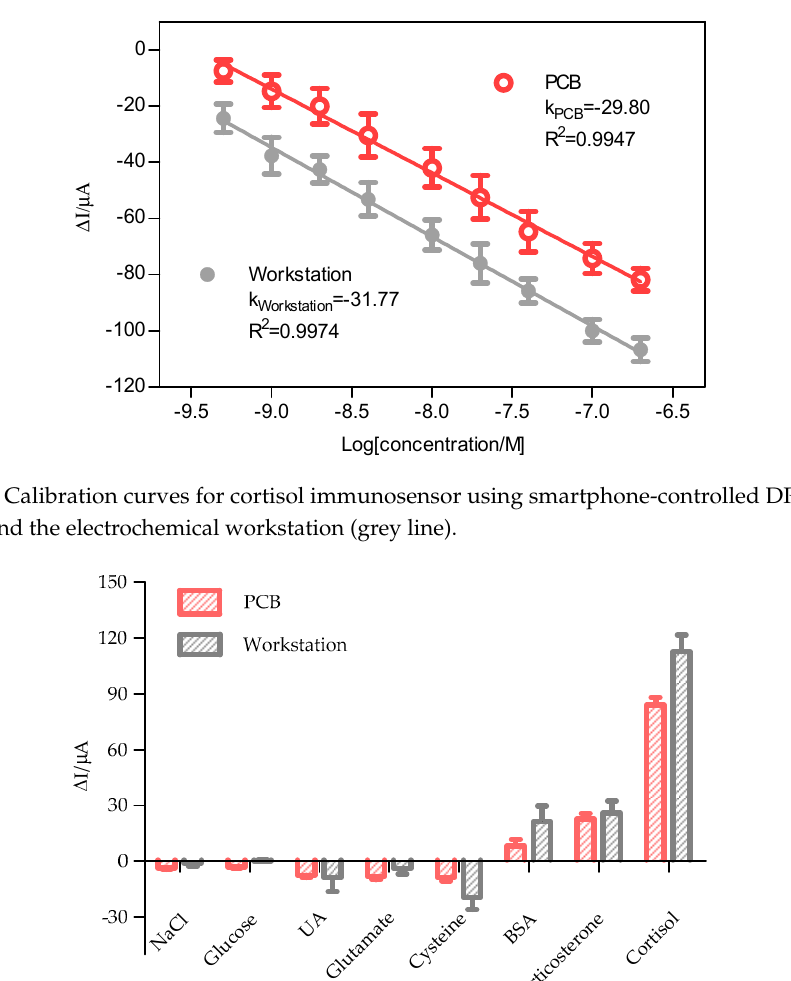
Figure A1. Energy-dispersive X-ray spectroscopy (EDS) image of AuNPs/MoS 2 /AuNPs-modified screen-printed electrode.